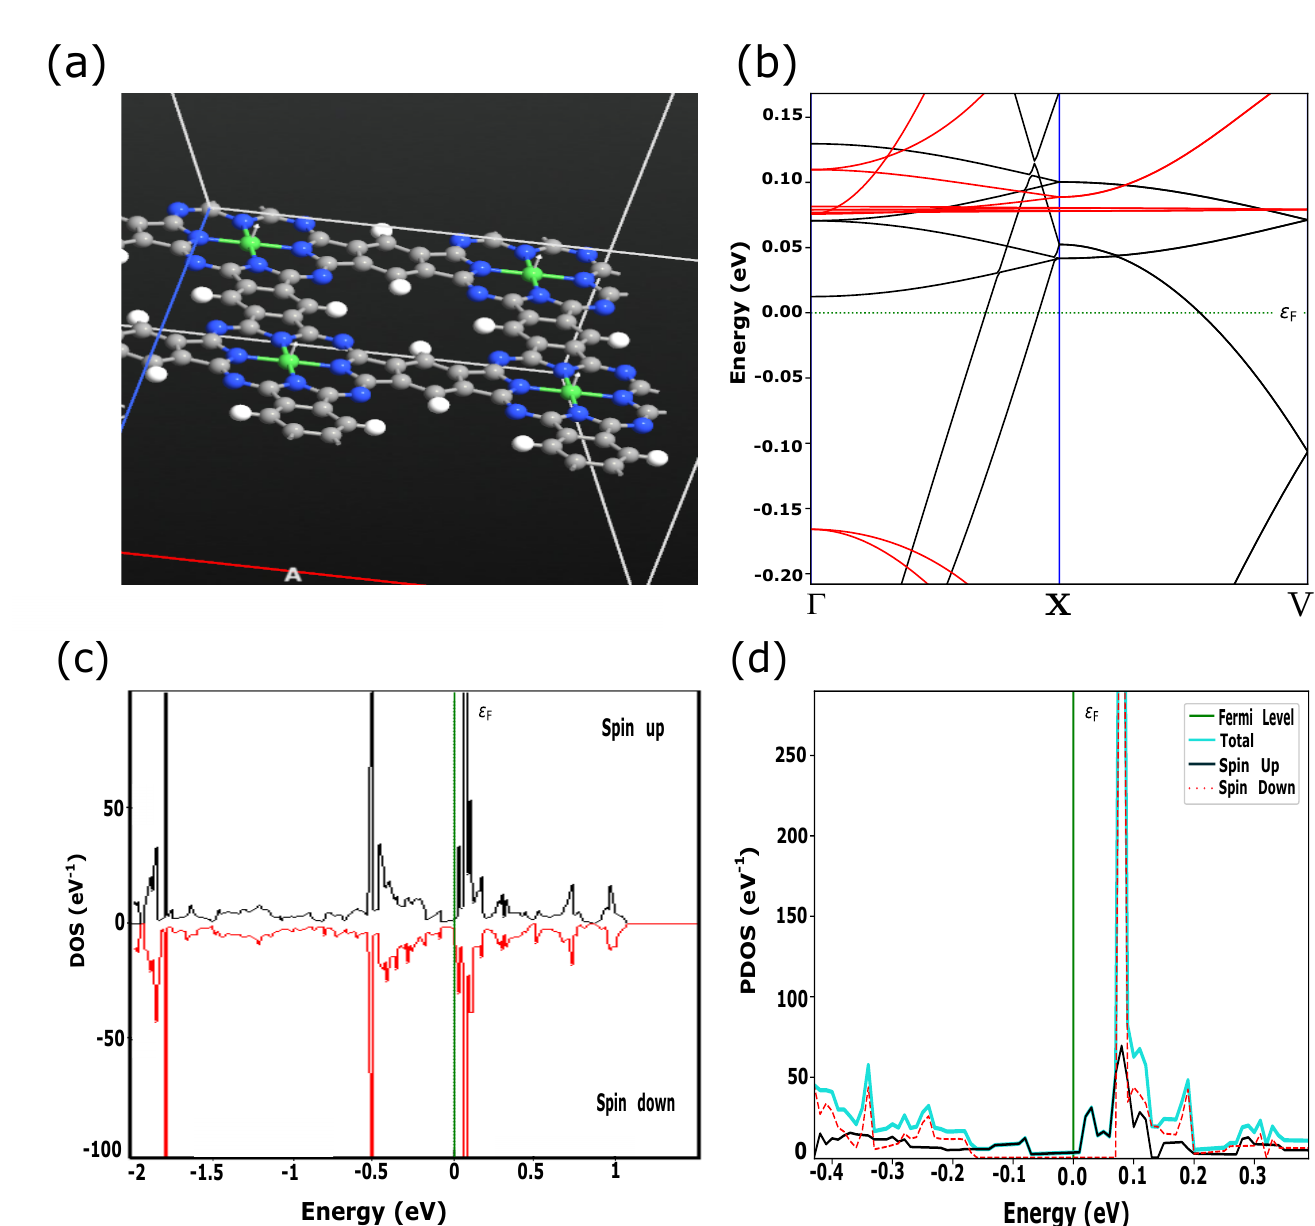
Figure 3. ( a ) NiPPC supercell with parallel magnetic moments in Ni (white arrows); ( b ) spin up (black) and spin down (red) dispersion bands. ( c ) Spin-resolved DOS for NiPPC; ( d ) PDOS, where the highest peak near ε F is related to spin down band